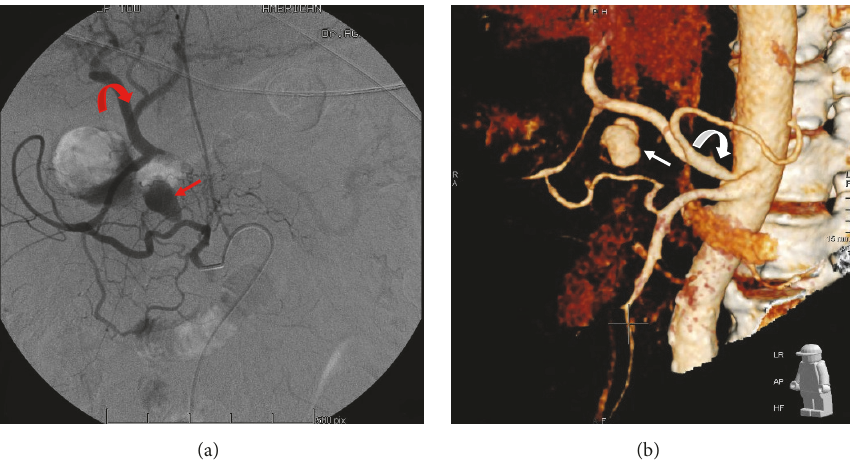
Figure 4: Selective digital subtraction angiography (DSA) of the superior mesenteric artery : (a) A 2.0- × 1.4-cm narrow neck oblong aneurysm (Arrow) originating from the anterior branch of the inferior pancreaticoduodenal artery. Note the several collaterals originating from the superior mesenteric artery and the retrograde filling of the hepatic artery (Curved arrow) through the pancreaticoduodenal arcade. (b) Three- dimensional reconstruction of the enhanced CT images revealing the oblong aneurysm (Arrow) , originating from a branch of the superior mesenteric artery. Note the stenosis at the origin of the celiac trunk (Curved arrow).